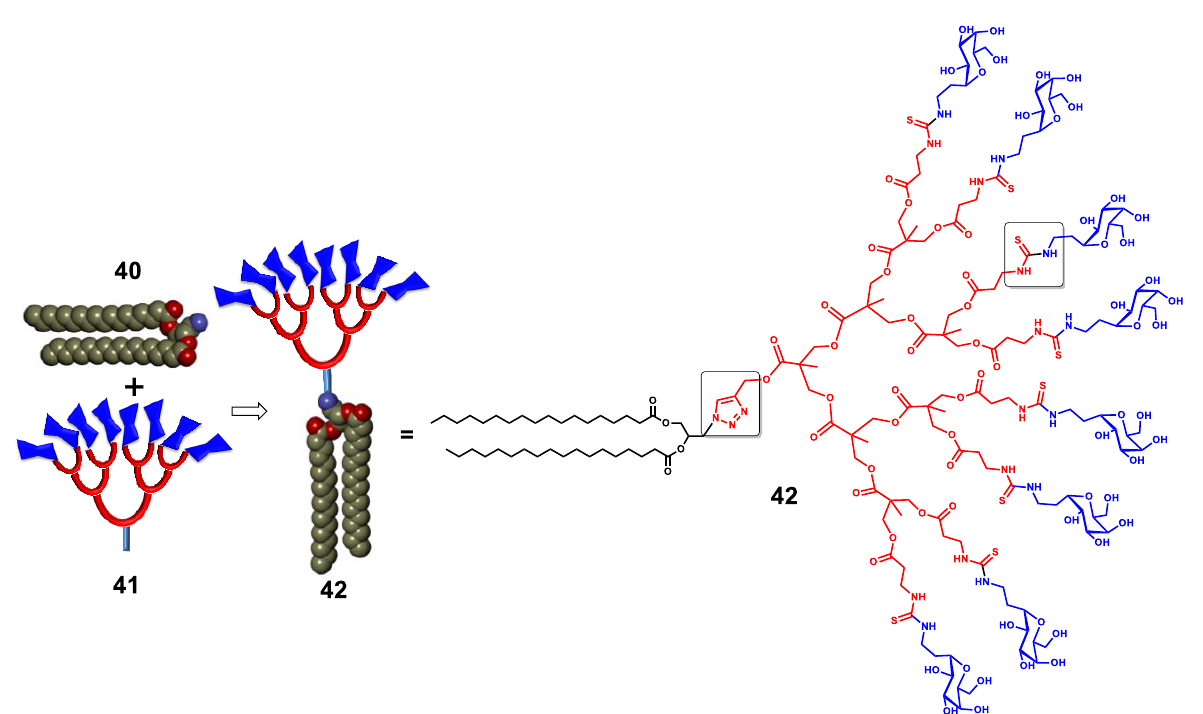
Scheme 7. Amphiphilic arborescent neoglycolipid (glycodendrimersome precursor) ( 42 ) built from known